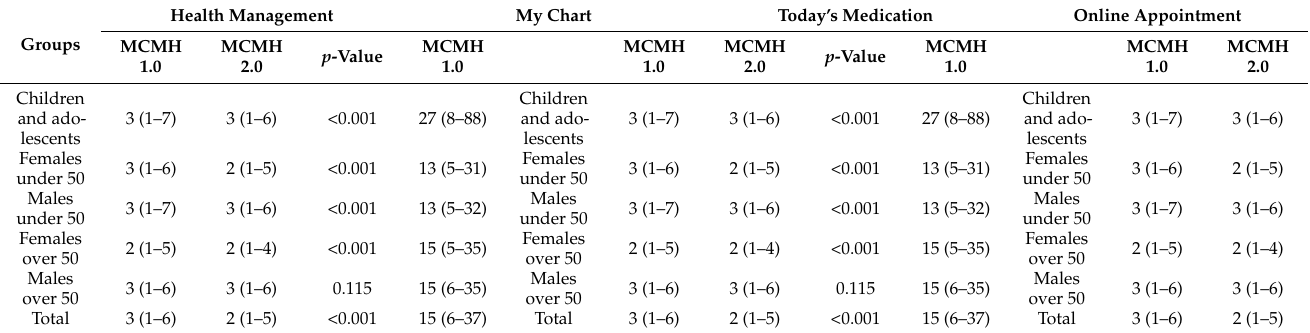
Table 5. Monthly access count per user in MCMH 1.0 and MCMH 2.0 according to age and sex groups.